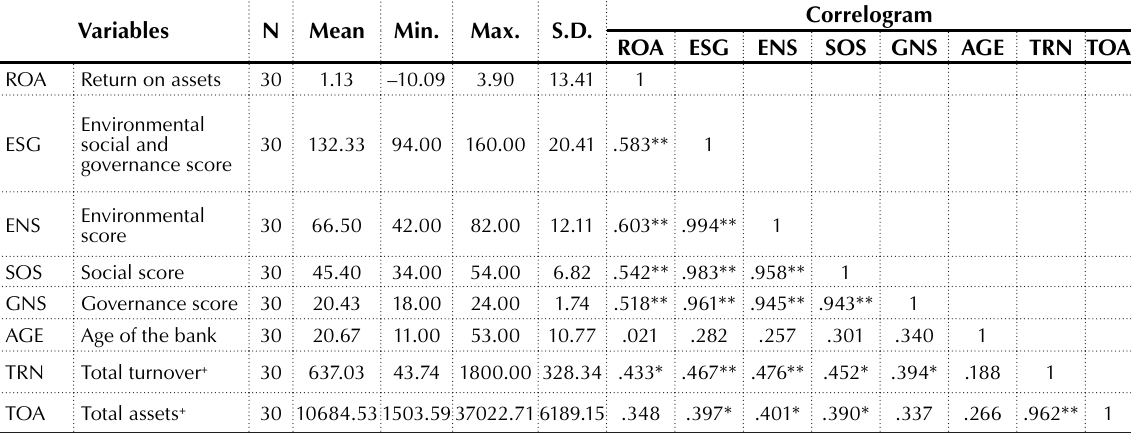
Table 2. Descriptive statistics and Pearson correlations